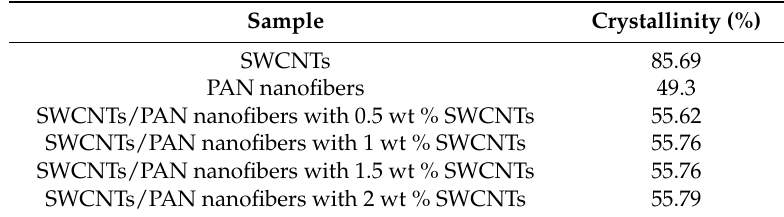
Table 2. The crystallinity of SWCNTs, PAN nanofibers, and corresponding composite nanofibers with the different SWCNT concentrations.